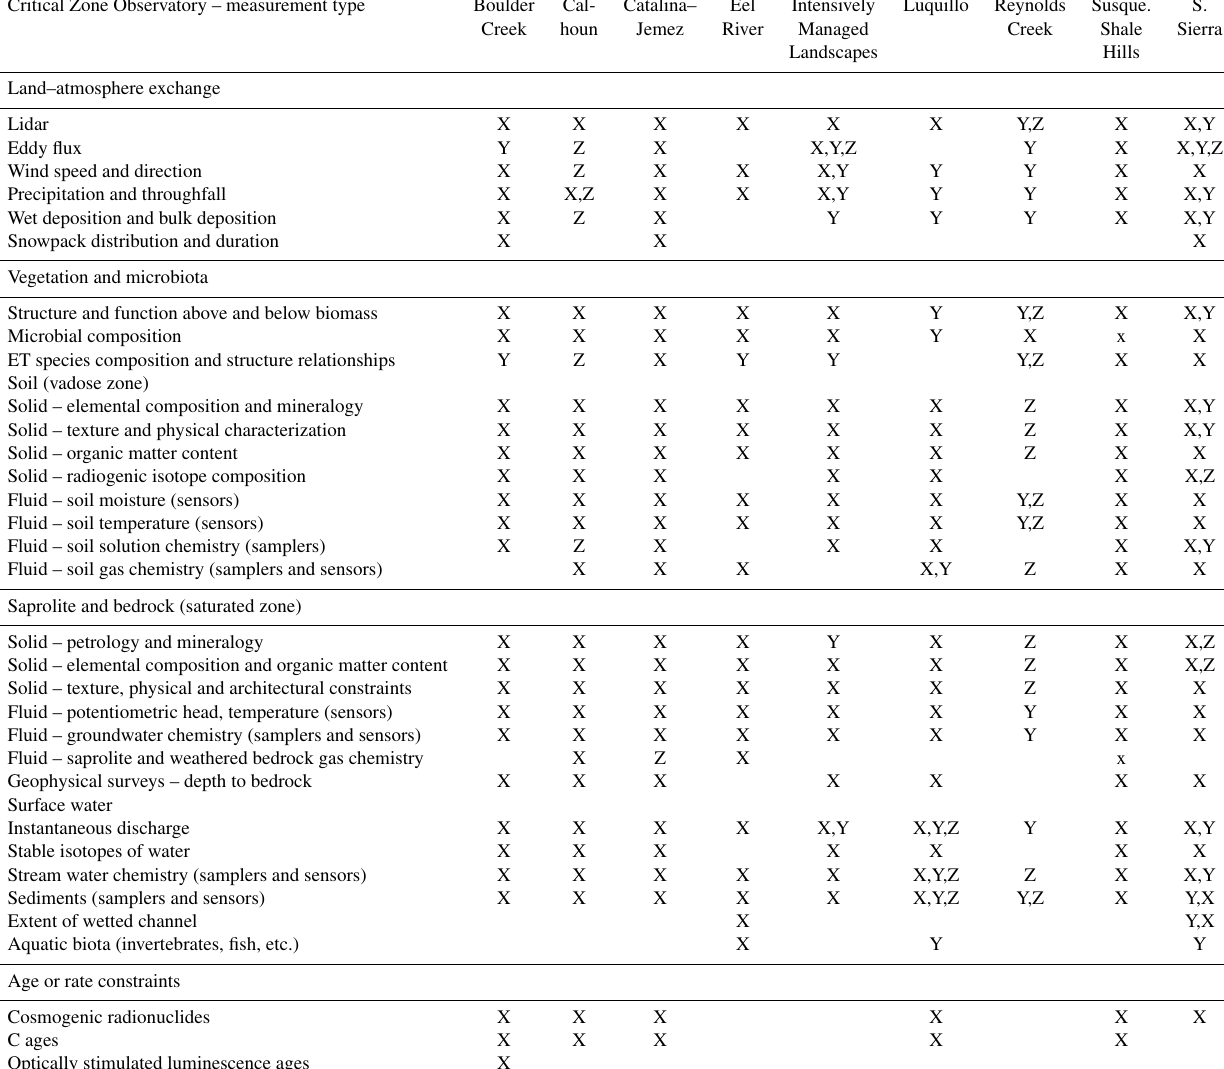
Table 2. Common measurements made in the CZO network in the United